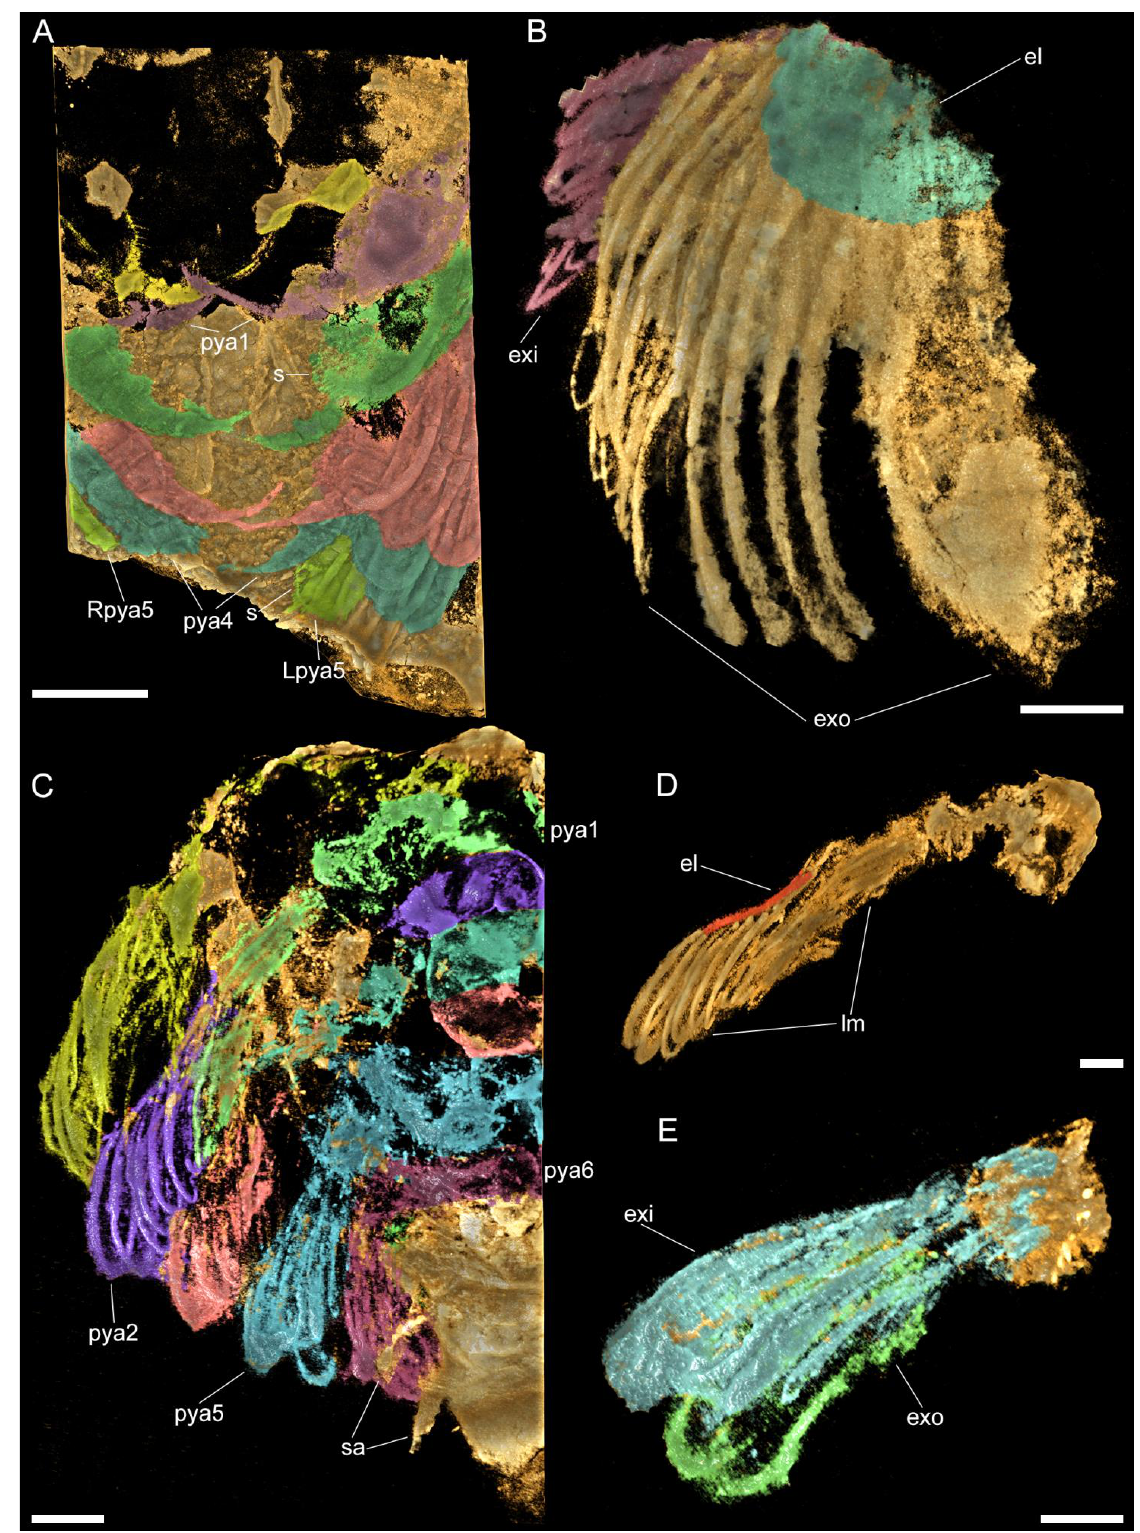
Figure 5. Images rendered from 3D tomographic models of Retifacies abnormalis (( A , B ) rendered from YKLP 11430, see Figure 1E; ( C – E ) rendered from YKLP 11432, see Figure 4C). ( A ) Ventral view of pygidial appendages (each shown in a different false colour). ( B ) Ventral view of the exopodite